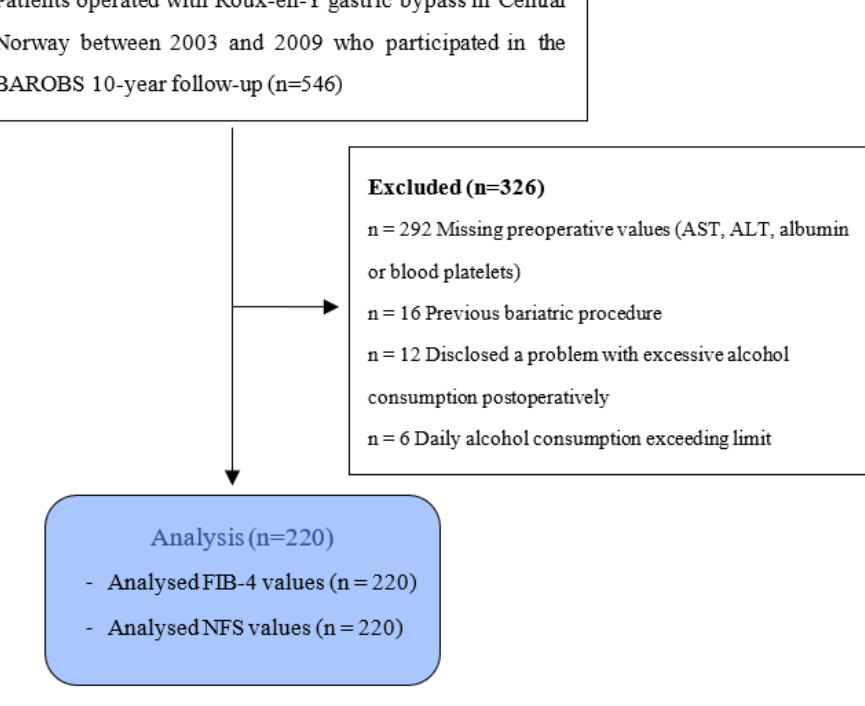
Figure 1. Flow-chart of the study population.